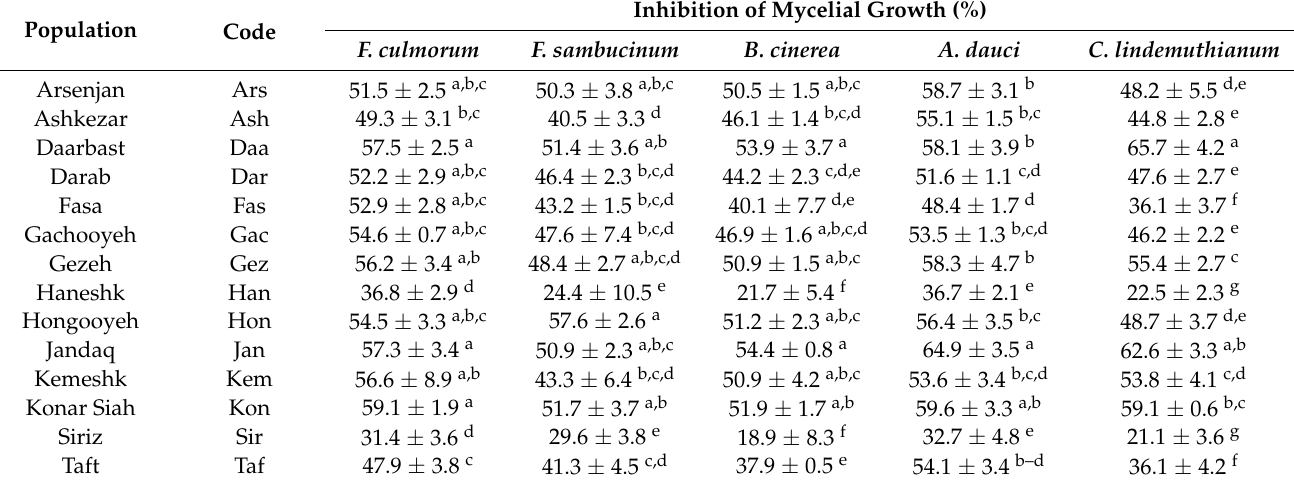
Table 1. Antifungal activities of hydroethanolic leaf extracts from plants of 14 Z. multiflora popu- lations against five phytopathogenic fungi. Mean growth inhibition rates and standard deviations determined from three leaf samples per population are shown. Mean values in a column that do not have a common letter are significantly different (Fisher’s least significant difference test, p adj ≤